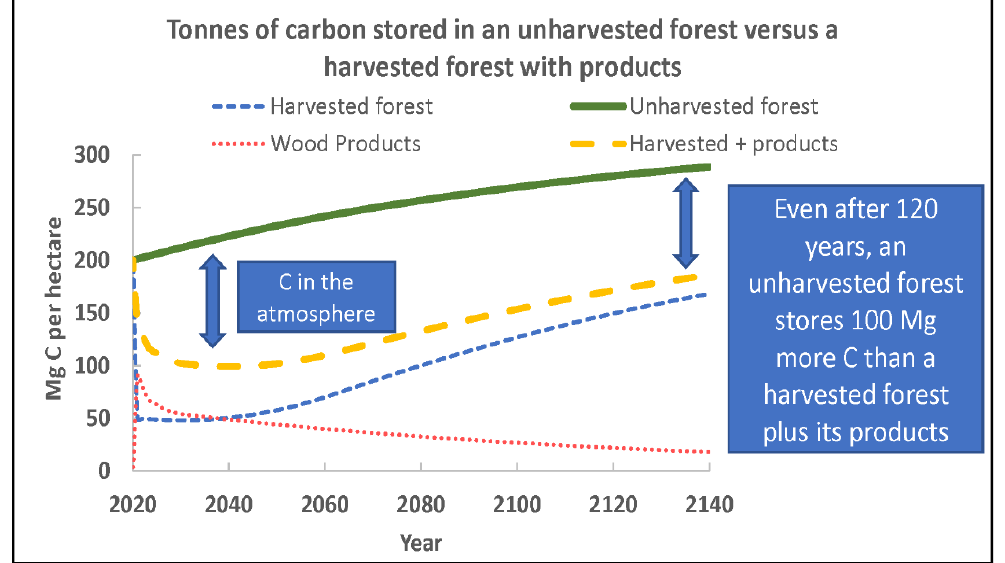
Figure 2. A mature forest with a carbon density of 200 tons of carbon per hectare (green line) is harvested (blue line) in 2020. This results in an immediate reduction of live tree carbon stocks. Approximately half of the aboveground carbon is removed and taken to the mills (as wood) while the other half remains behind in slash piles (leaves, bark, branches, etc.) and in the dead belowground roots. The slash is burned on-site and the carbon is immediately emitted to the atmosphere. The roots decompose over the next few decades, emitting carbon to the atmosphere. The carbon taken to the mill as wood is processed into short- and long-term wood products (red line), that decay over years to centuries, eventually returning the carbon to the atmosphere. Estimates comparing the carbon benefits of wood products to alternative materials have been found to overestimate the benefit by factors of between 2- and 100-fold by not counting the full life cycle carbon and the shorter durability of wood relative to alternative materials [33].